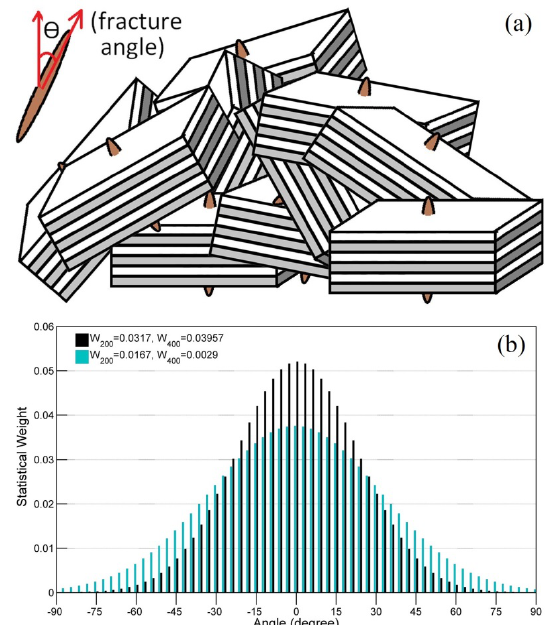
Figure 2 (a) Schematic diagram of clay sub-­‐‑composite embedded with hydrate-­‐‑filled fractures approximated as ellipsoid for effective medium modeling. (b) Two